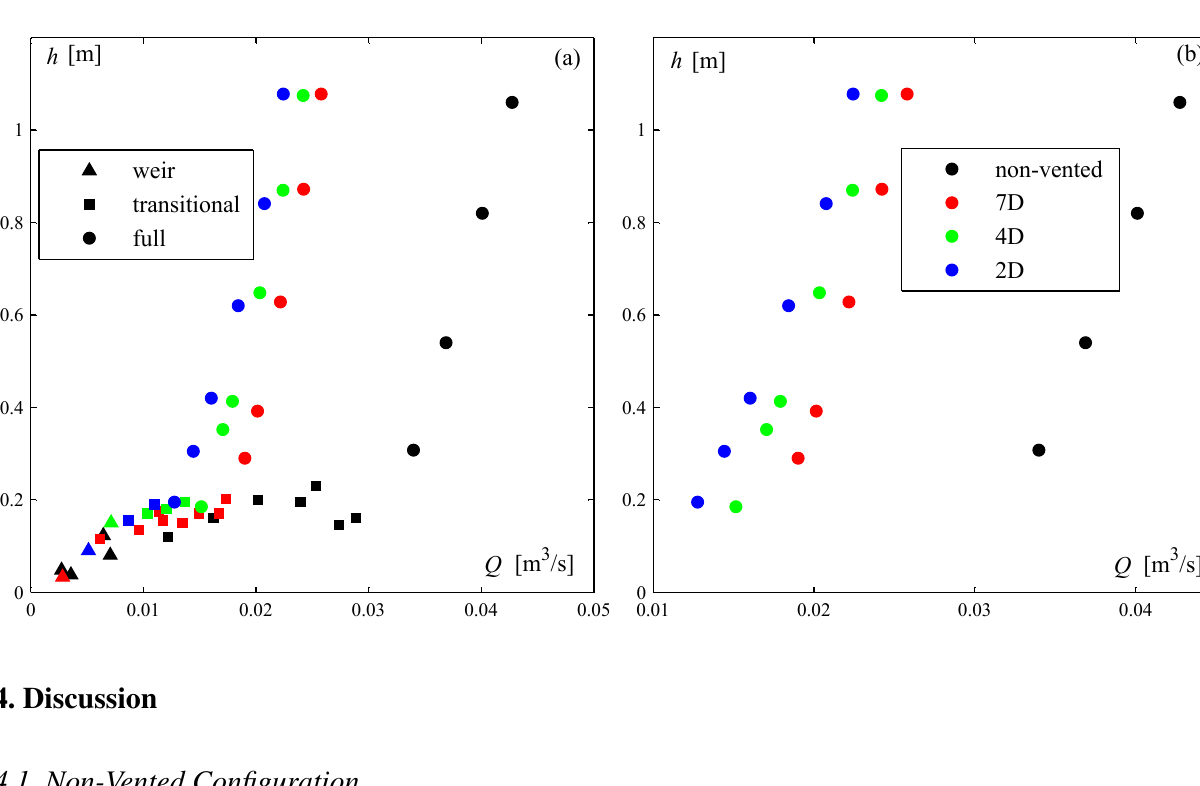
Figure 4. ( a ) Experimental data and ( b ) focus on full flow